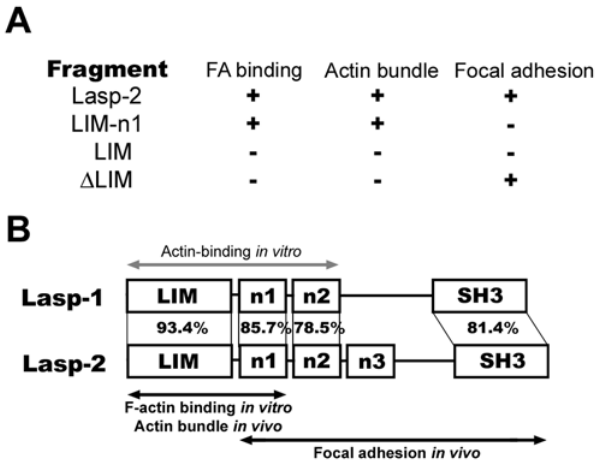
Figure 5. The predicted functions of structural domains in lasp-2. The results of this study are summarized in A. ( + ) indicates interaction with actin filaments, localization to actin bundles in NG108-15 cells, or focal adhesion in C2C12 cells. ( 2 ) indicates negative results compared to ( + ). The identities of the amino acid sequences of the LIM domain, first nebulin- repeat region, and SH3 domain between lasp-1 and lasp-2 are shown in B. The grey double-headed arrow above lasp-1 indicates the region containing actin-bindingactivityasreportedbySchreiberetal.(1998).Theblackdouble- headed arrows under lasp-2 show the regions responsible for localization to focal adhesions and interaction with F-actin in vitro and in vivo .